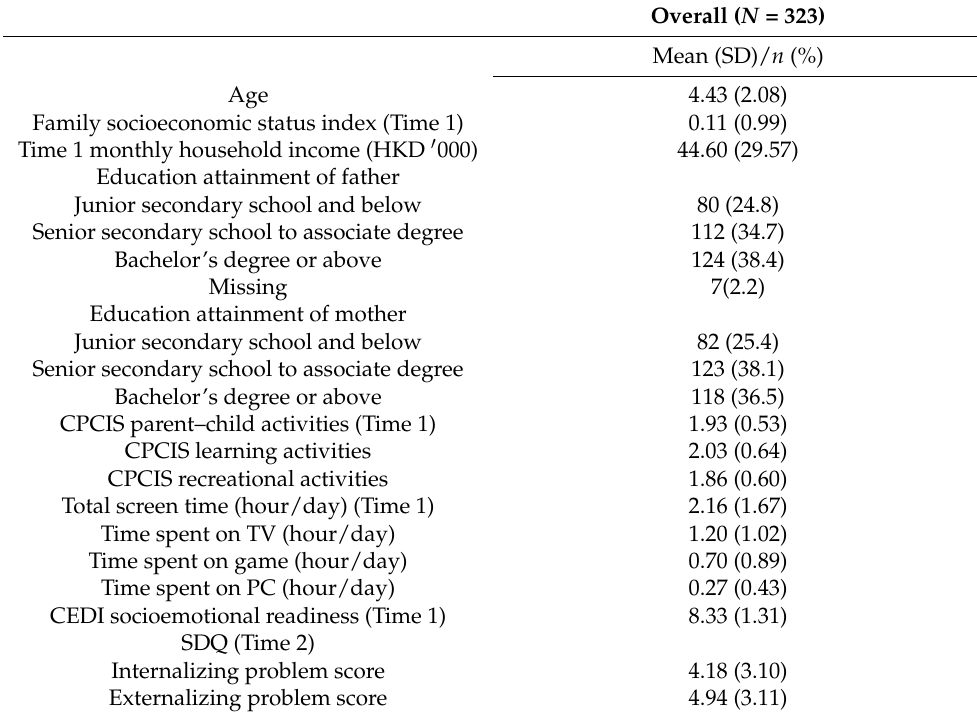
Table 1. Subject